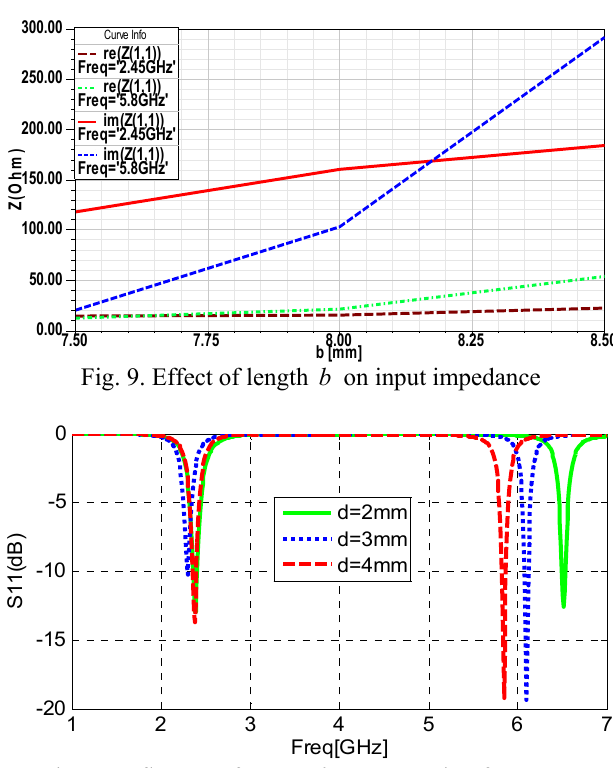
Fig. 10 Influence of space d on resonating frequency